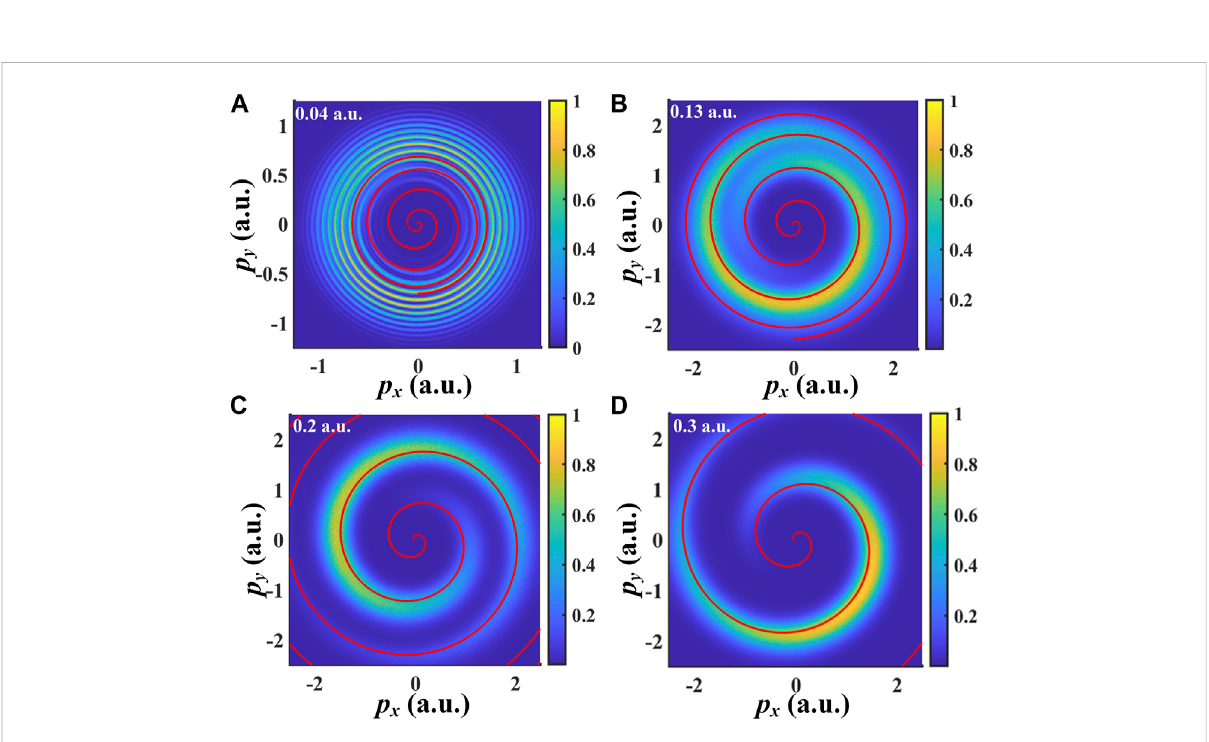
FIGURE 3 The photoelectron momentum spectra calculated by SCM, corresponding electric fi eld strength are (A) 0.04 a.u. (B) 0.13 a.u. (C) 0.2 a.u. (D) 0.3 a.u. The fi eld-driven momentum − A ( t i ) is shown by the red